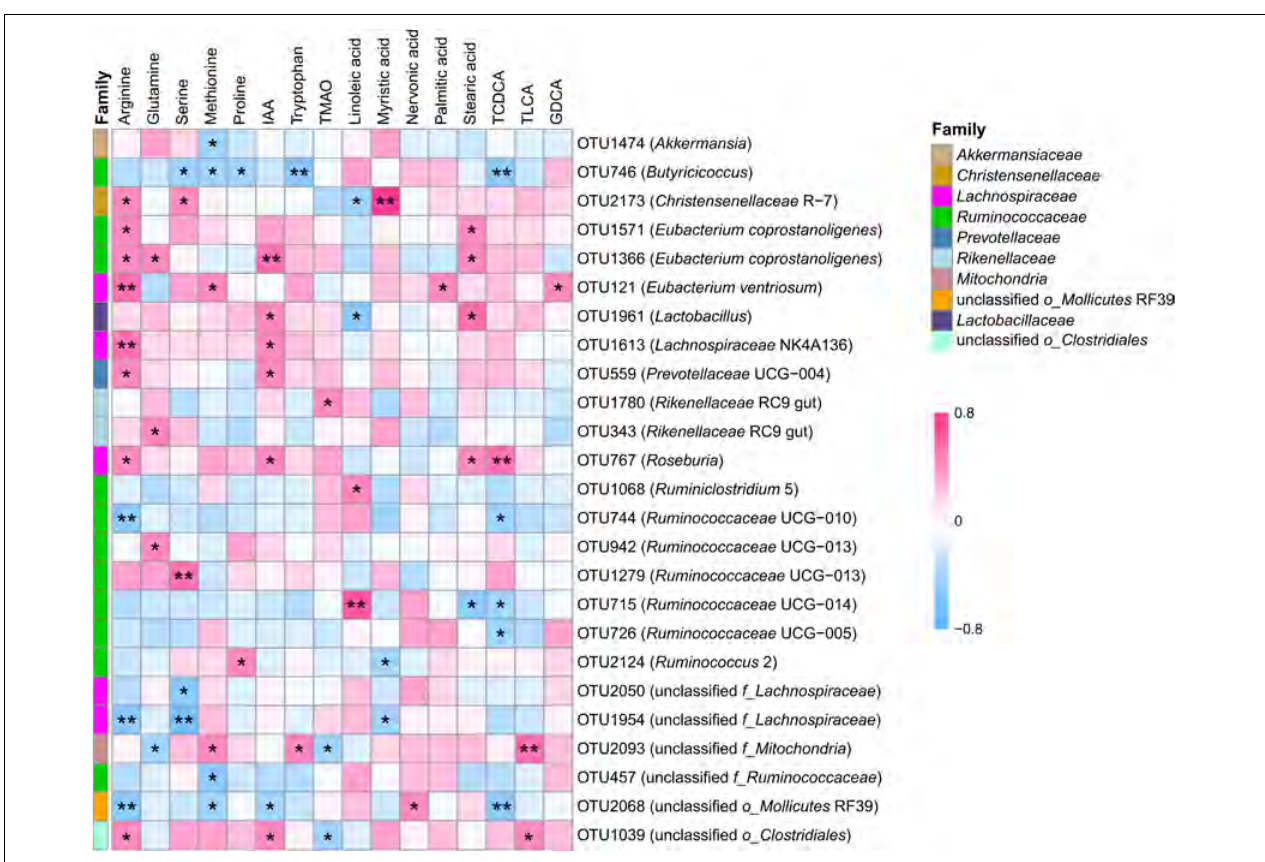
FIGURE 4 | Correlation between transplantation-sensitive operational taxonomic units (significantly differed OTUs) and serum metabolites following rumen fluid transplantation. Red represents a positive correlation, and blue represents a negative correlation. Only strong (Spearman’s |r| > 0.40) and significant ( P < 0.05) correlations are presented in the figure. * P < 0.05, ** P <